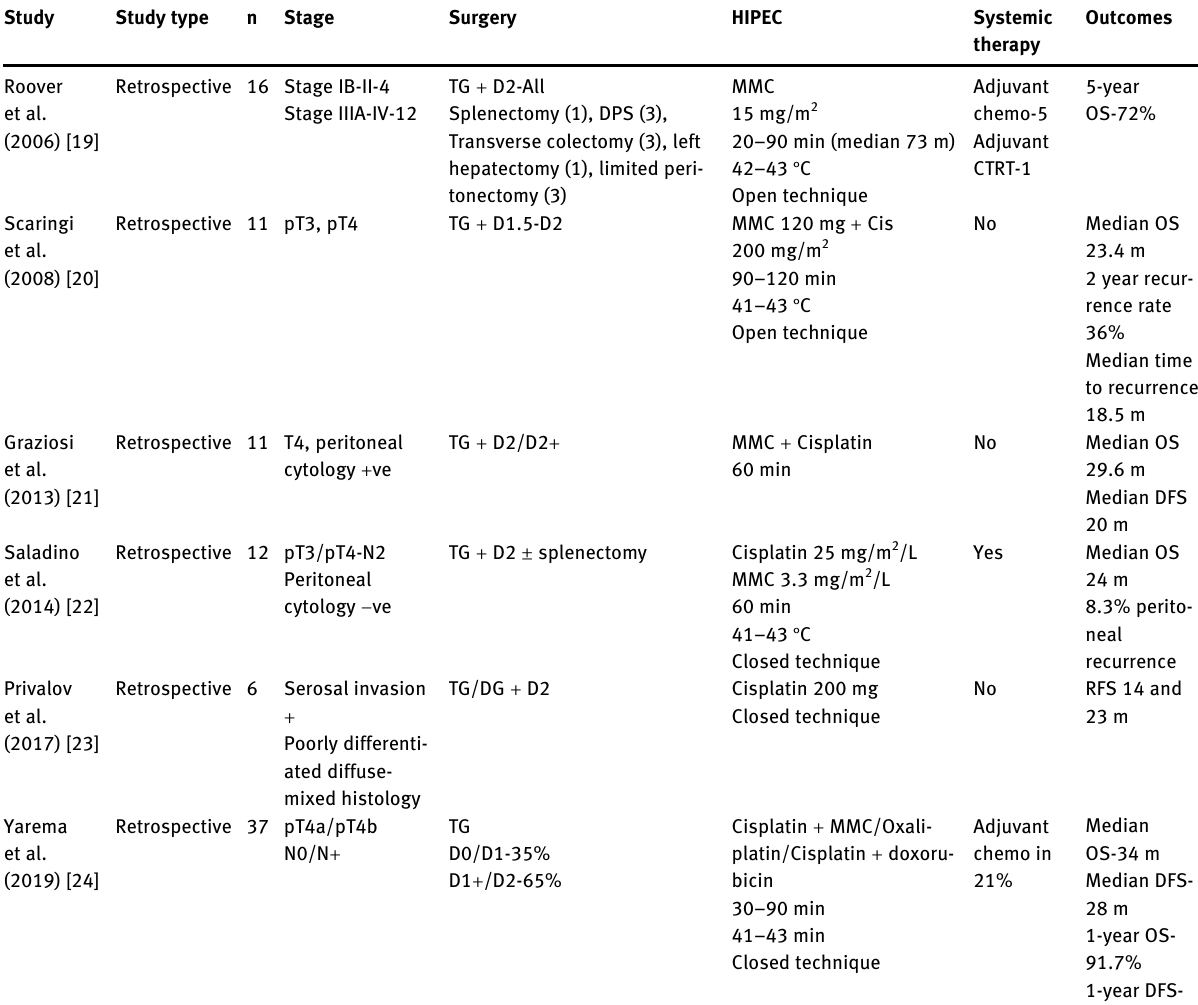
Table  : Retrospective non-comparative studies for